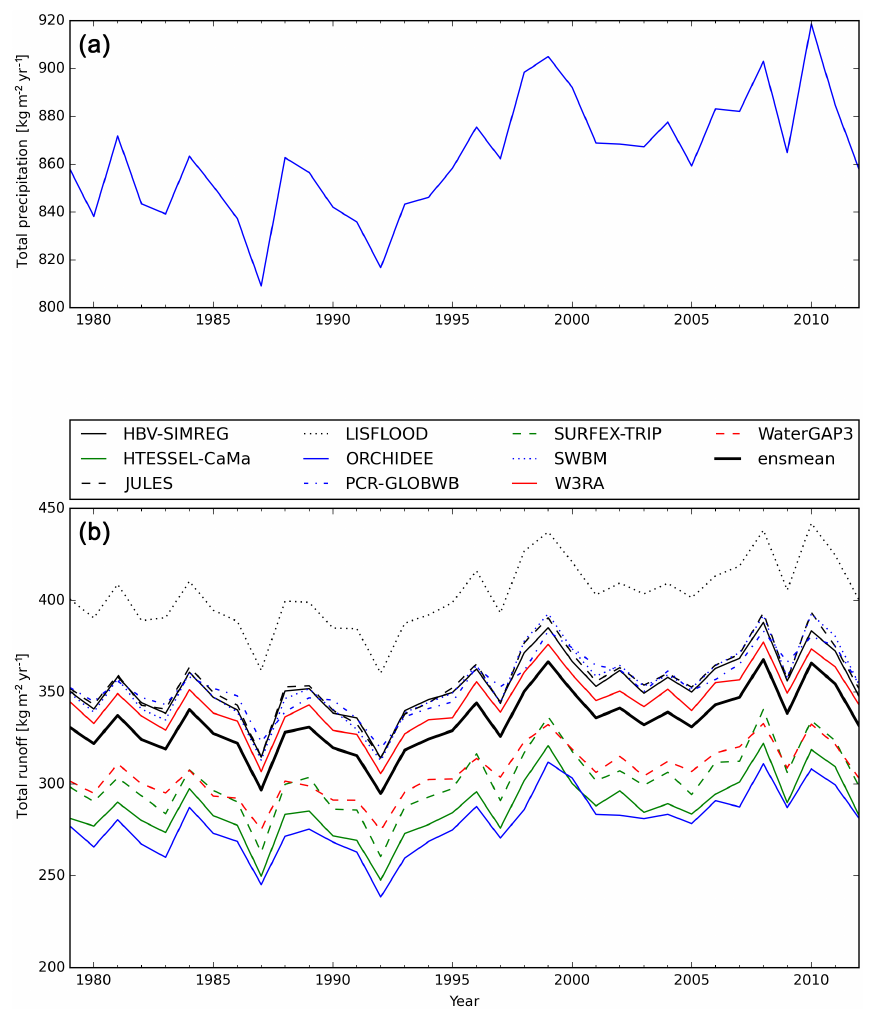
Figure 9. Global mean yearly precipitation (a) and runoff (kgm − 2 yr − 1 ) for all models (b) . The thick black line represents the ensemble